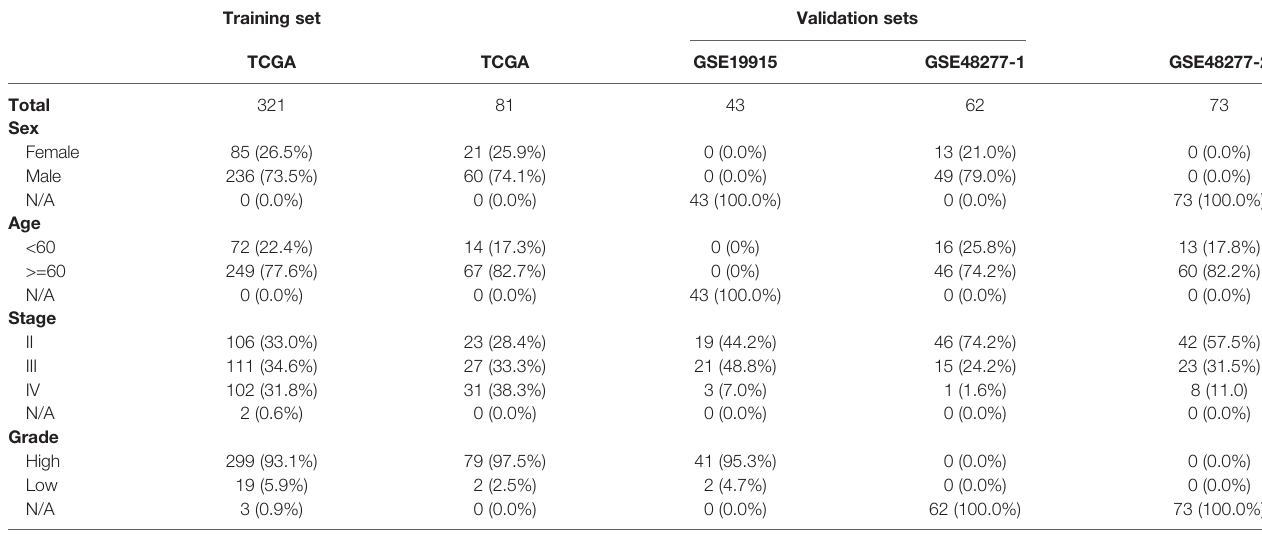
TABLE 1 | Basic information of training and validation datasets for MIBC subtyping